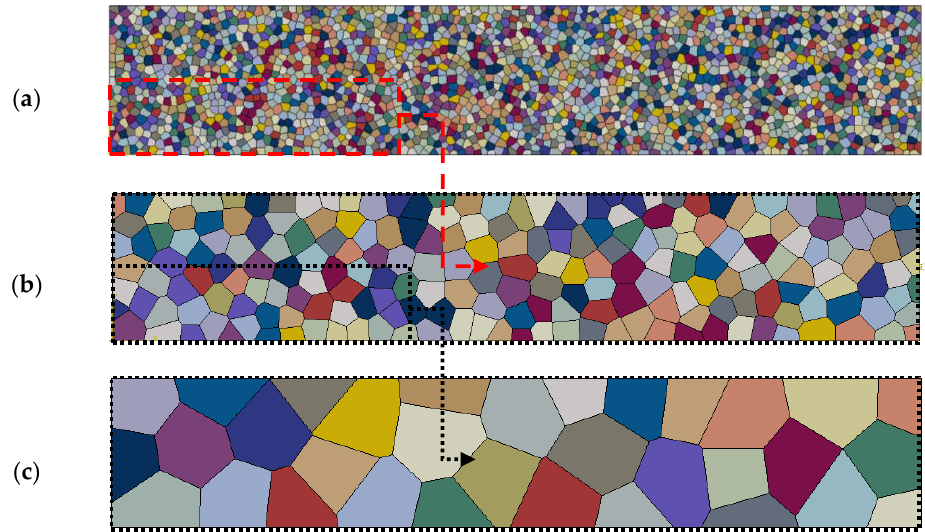
Figure 7. RVE for T 11 : ( a ) 0.511 × 0.091 mm × mm with 6633 grains (RVE#1); ( b ) 0.089 × 0.0158 mm × mm with 199 grains (RVE#2); ( c ) 0.00035 × 0.00006 mm × mm with 32 grains (RVE#3).